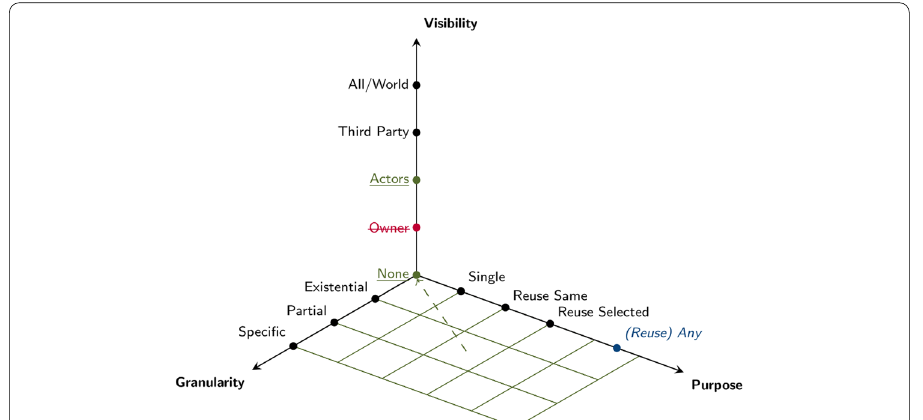
Fig. 6 Modified privacy dimensions for EV charging use cases. Green underlined values denote redefinitions, struck out red values denote removals and the purple italic value denotes the combination of two